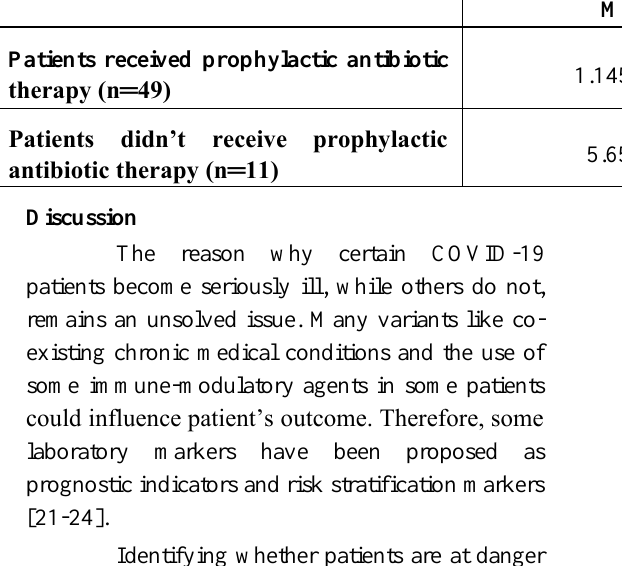
Table 3. Relation between procalcitonin values and prophylactic antibiotic therapy.